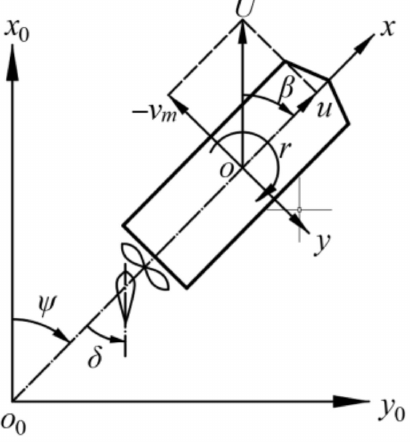
Figure 1. Coordinate